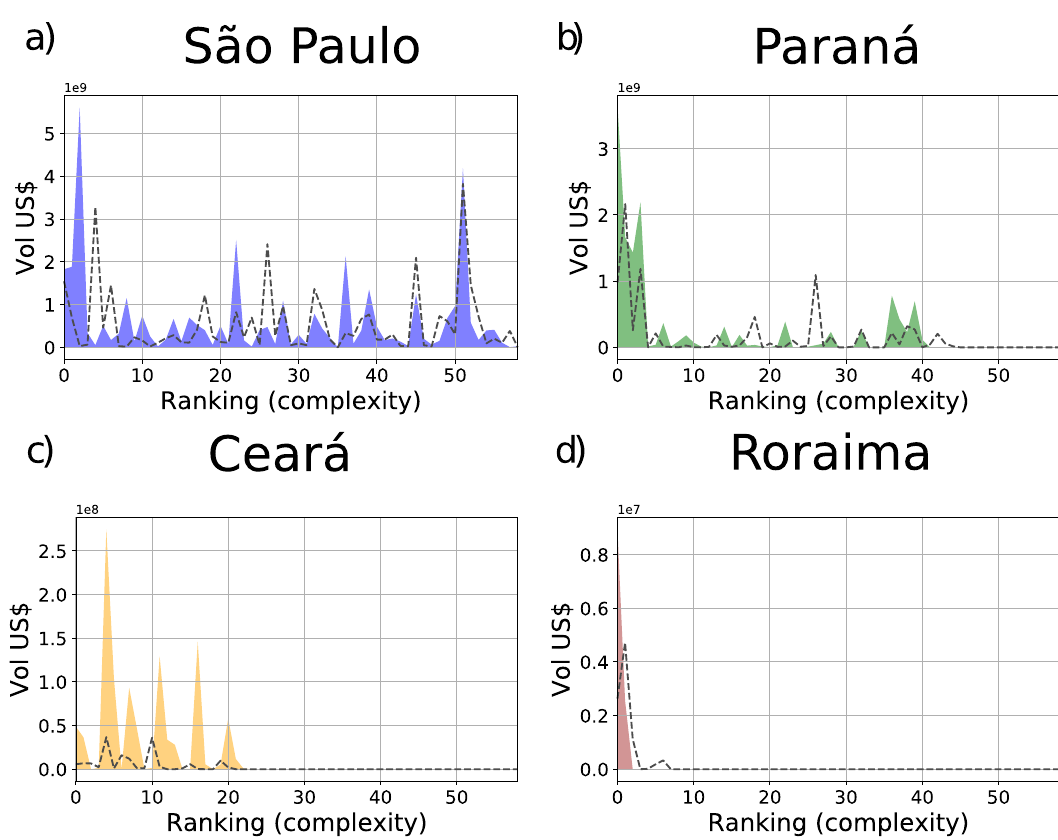
Fig 2. Products spectroscopy of the years 2005 (dotted lines) and 2015 (filled colors) of the states: a) S ã o Paulo, b) Parana´, c) Ceara´, and d) Roraima. The figures show the export volume (in US Dollars) of those states for each product with M according to their Complexity. Products are grouped in bins of 10 and the export volume in each bin are summed up.